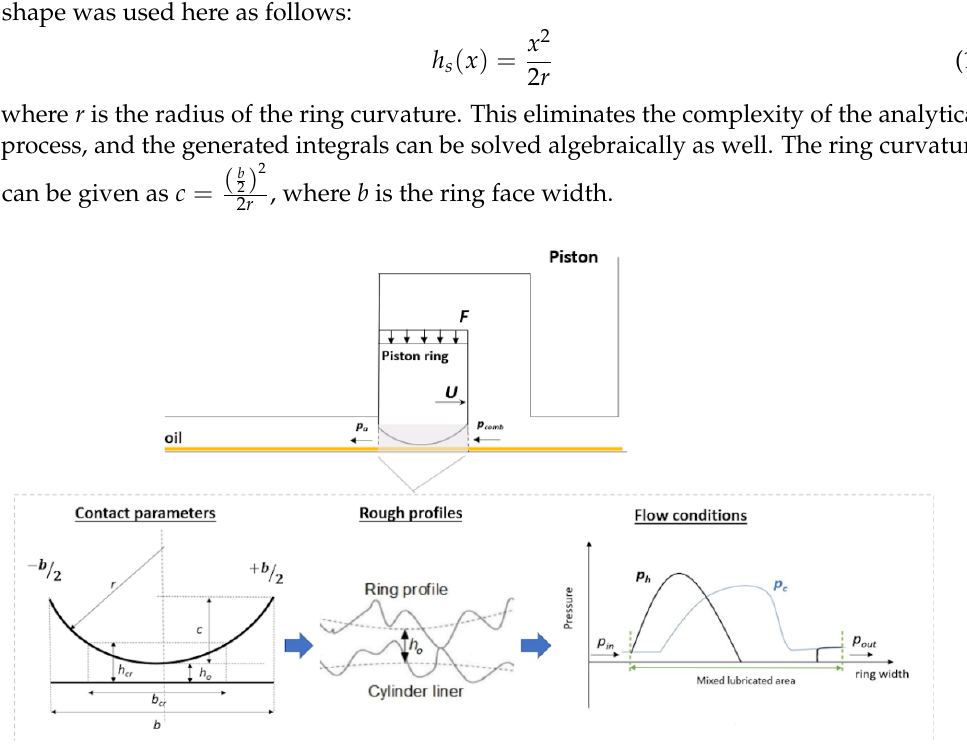
Figure 1. Contact parameters and flow conditions in piston ring–liner conjunction.